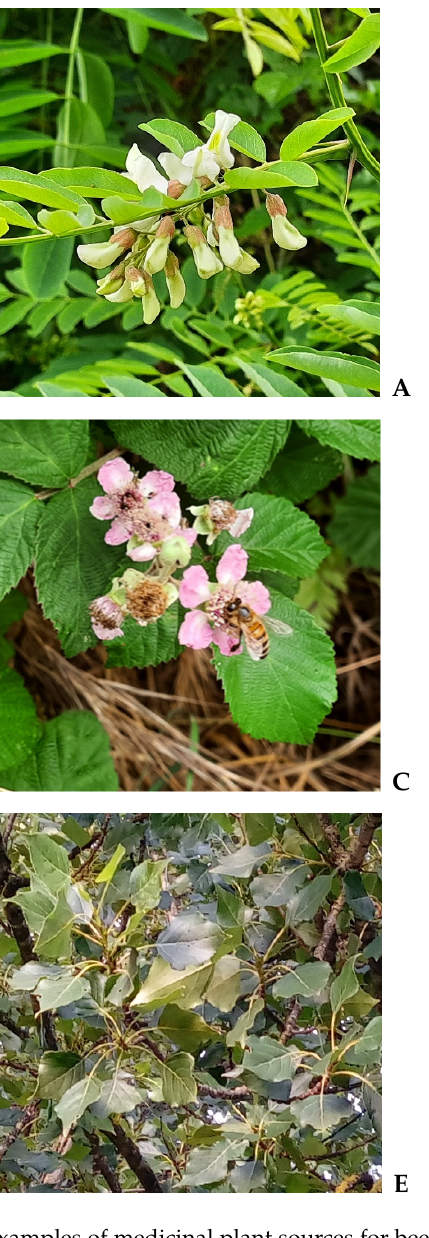
Figure 2. Examples of medicinal plant sources for bees: ( A ) Robinia pseudoacacia (nectar), ( B ) Tilia cordata (nectar, pollen, honeydew), ( C ) Rubus ulmifolius (nectar), ( D ) Eucalyptus camaldulensis (nectar, pollen, honeydew), ( E ) Populus nigra (propolis), ( F ) Pinus pinaster shoot heavily infested by Toumeyella parvicornis (pine tortoise scale,